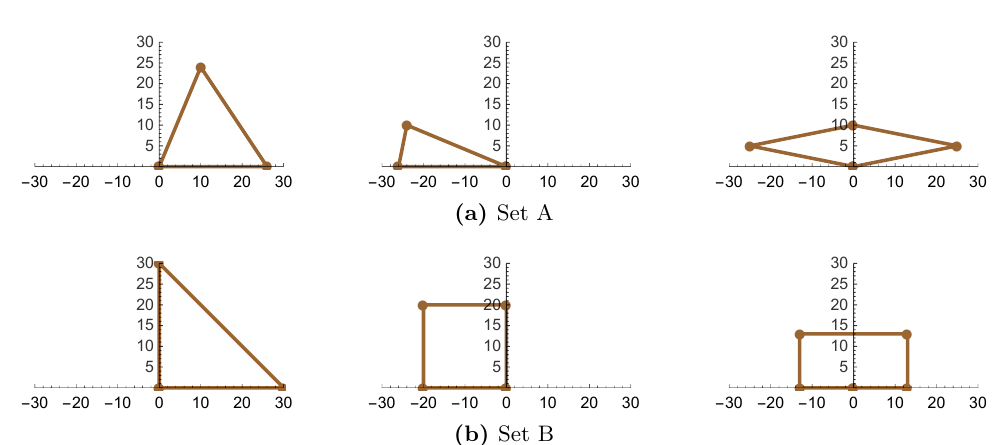
Figure 2. Basic Wilson loop operators.